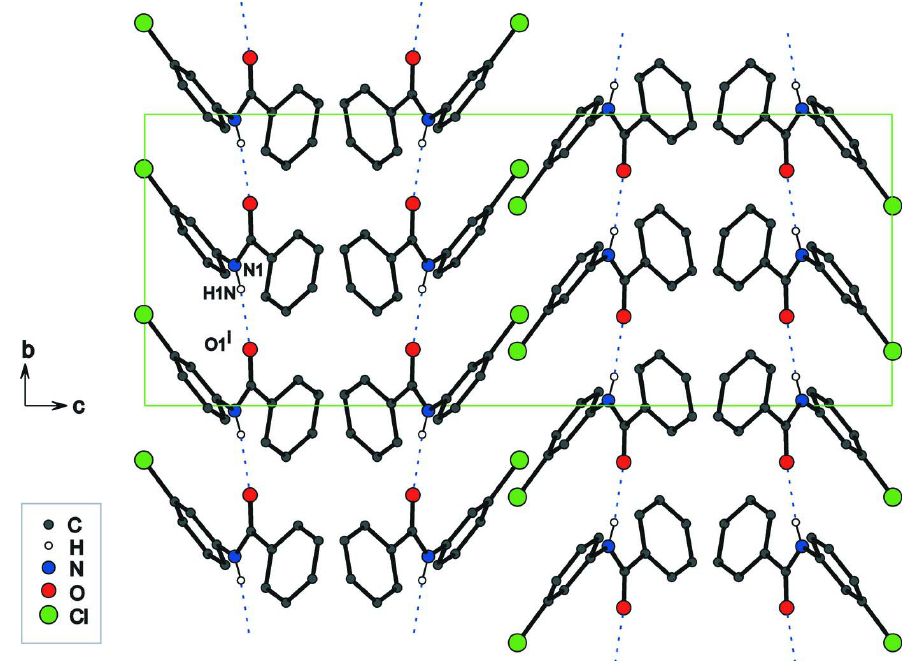
Figure 2 Crystal structure of the title compound viewed down the axis a. One-dimensional chains along the base vector [0 1 0] are formed by hydrogen bonds N1–H1N···O1(i). H atoms not involved in hydrogen bonding are omitted. [Symmetry code: (i) - x + 1/2, y - 1/2, z